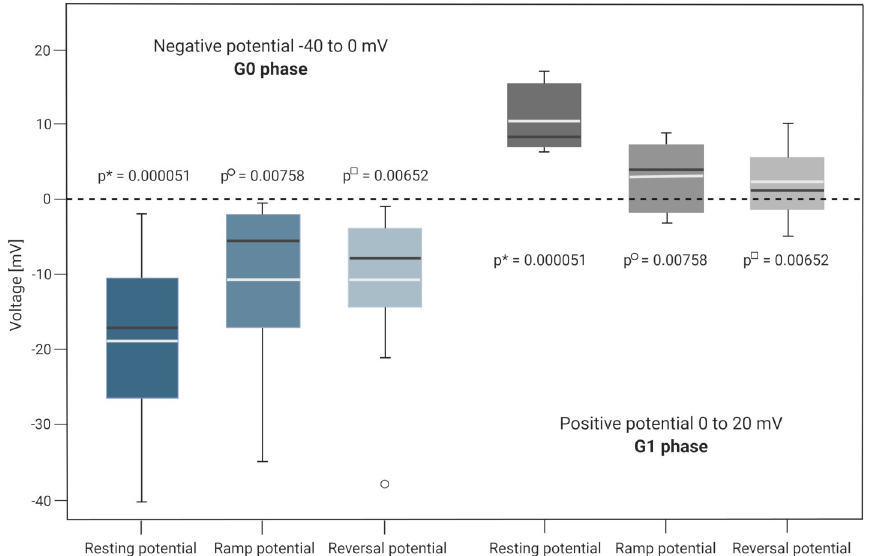
Fig 4. Resting potential, ramp potential and reversal potential in G0 and G1 cell cycle phase. Resting membrane potentials measured in current-clamp mode, reversal potentials from voltage-ramp measurements and derived reversal potentials from current-voltage curves in negative (G0 phase) and highly depolarized (G1 phase) A549 cells. Black lines in the boxplot indicate the median, white lines the mean value. Whiskers denote 10% and 90% percentiles. Single scores outside the 10% and 90% percentile are depicted as black circles. P-values demonstrate statistical significance between cells in G0 and G1 phase. Detailed measurement results are provided in S2 Table. Created with BioRender.